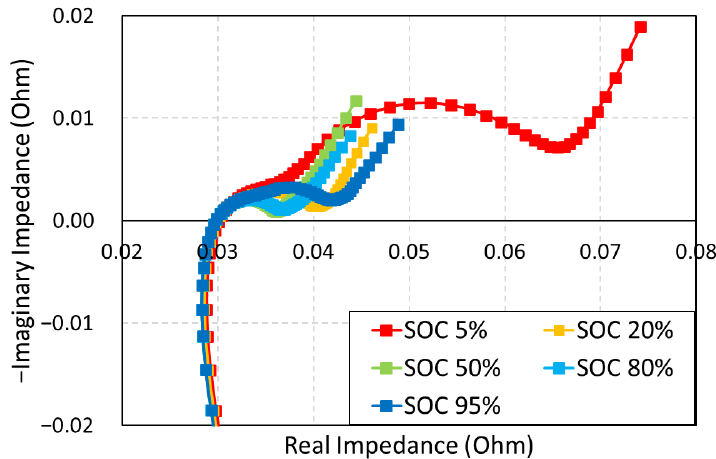
Figure 8. EIS measurements in a fresh cell at 5, 20, 50, 80 and 95% SOC.